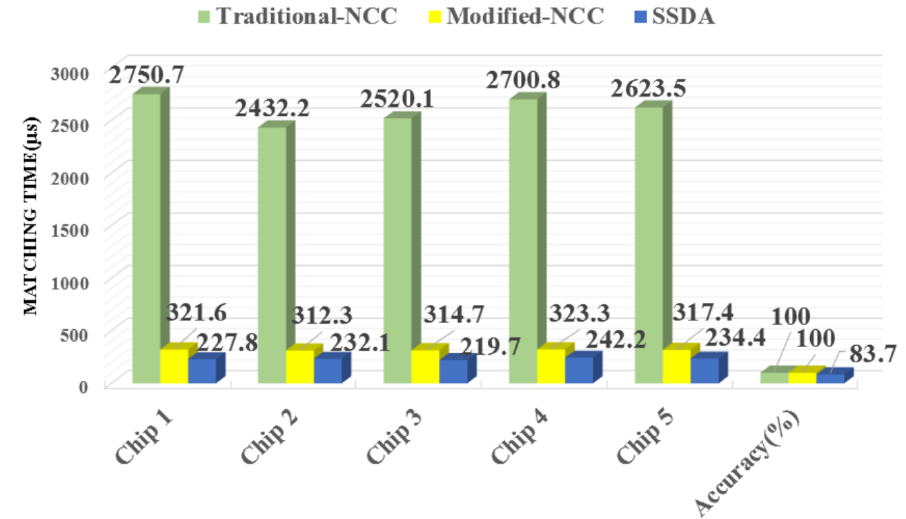
Figure 11. Performance of the modified NCC in matching time and